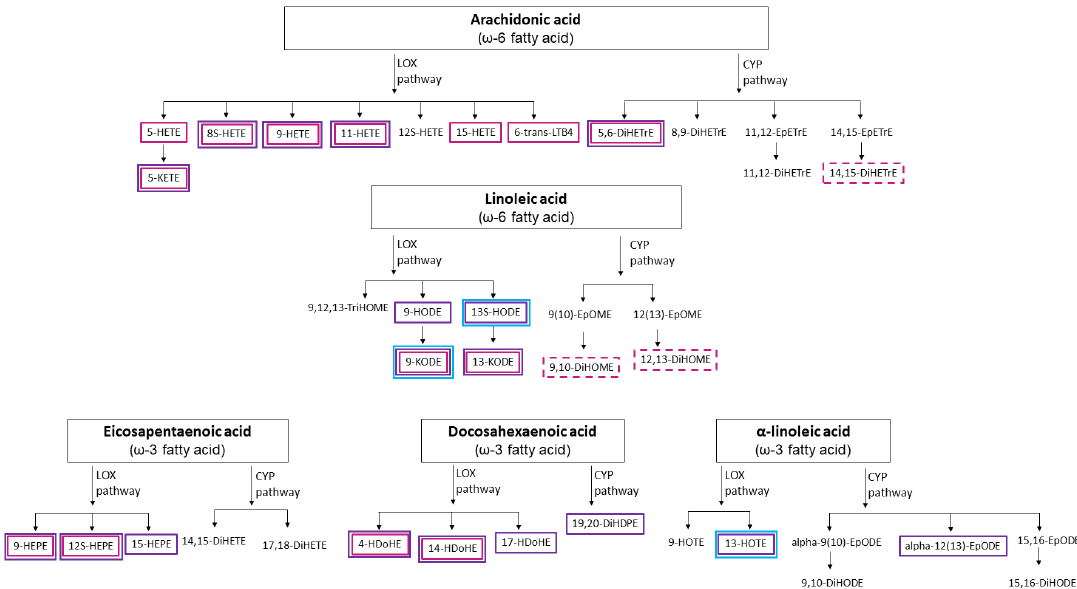
Figure 1. Polyunsaturated fatty acids and metabolic pathways that create the oxylipins examined in this report. Squares indicate significant associations ( p < 0.05, FDR ≤ 10%; Table S1) between oxylipins and D3-creatine muscle mass/weight (purple squares), gait speed (pink squares), or the Short Physical Performance Battery (blue squares). Non-dotted squares indicate positive associations and dotted squares indicate negative associations. Abbreviations: LOX—lipoxygenase; CYP—cytochrome P450 (oxylipin abbreviations are listed in Table S2). Not pictured: 10-Nitrooleate; 9,10-e-DiHO; and 9,10-EpO. Figure 2 is a volcano plot of the associations between the 42 oxylipins with respect to D3-creatine muscle mass/weight and physical performance, with a reference line at a p - value = 0.05. Almost all significant oxylipin associations with D3-creatine muscle Table 1. Characteristics among N = 463 MrOS men by tertiles of gait mass/weight, gait speed, and the Short Physical Performance Battery were positive. Figure 3 is a heatmap illustrating the pattern of oxylipin associations across the four outcomes. Gait speed, the Short Physical Performance Battery, and D3-creatine muscle mass/weight appeared to be similar with regard to the pattern of their associations with oxylipins. These three outcomes tended to be positively associated with fatty acid alcohols, fatty acid ketones, and fatty acid epoxides, and they shared both positive and negative associations with fatty acid diols (Figure 3); though not all these associations reached statistical signif- icance.